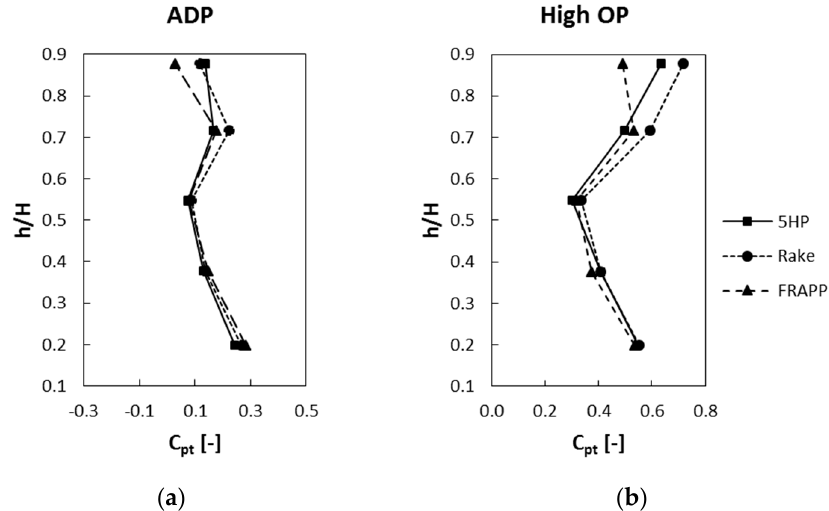
Figure 8. Comparison of C pt between 5HP, rake and FRAPP for ( a ) ADP and ( b ) high OP.